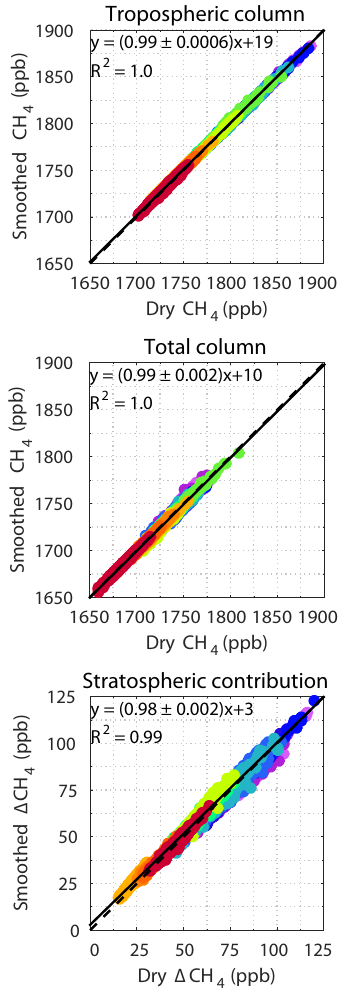
Figure B4. GEOS-Chem smoothed vs. dry integrated CH 4 DMFs for base simulation tropospheric columns, total columns, and strato- spheric contribution. Site colors are as in Fig. 1. Dashed lines mark the one-to-one